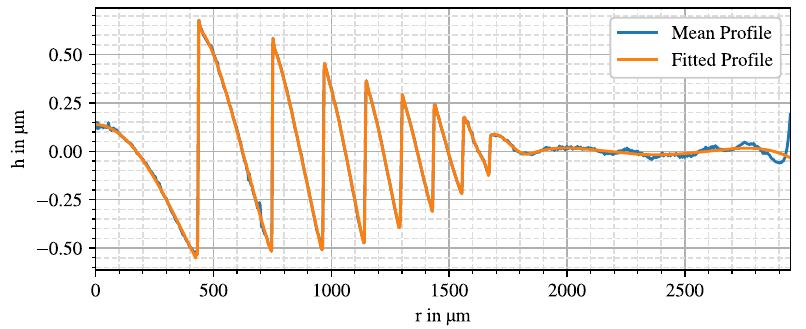
Figure 2. SN6AD1 anterior diffraction profile.